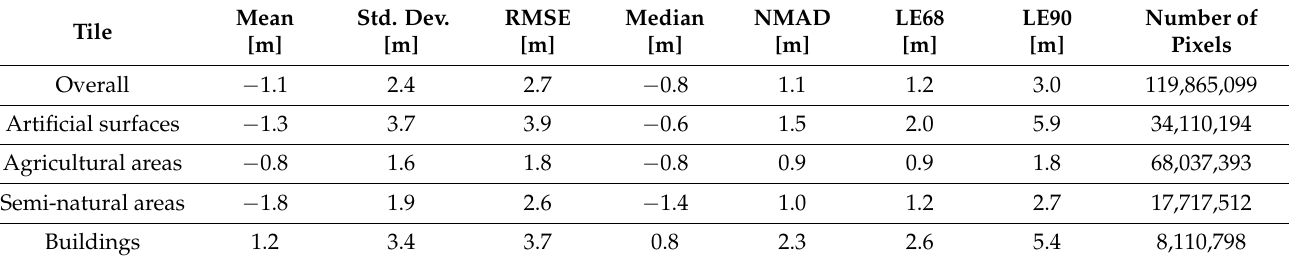
Table 2. Statistical indicators for DSM accuracy